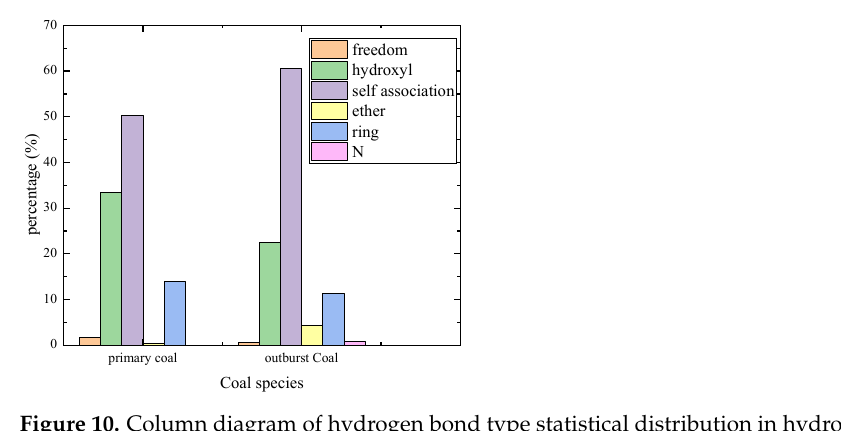
Figure 10. Column diagram of hydrogen bond type statistical distribution in hydroxyl group.